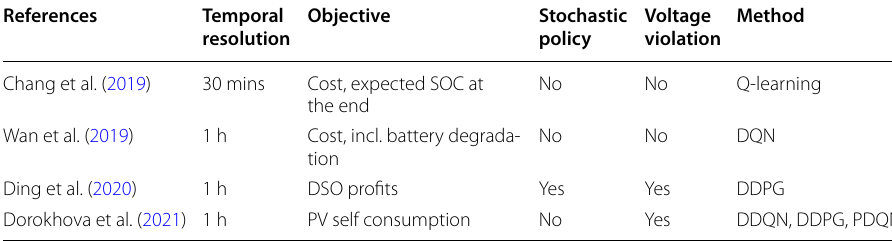
Table 1 Summary of some exemplary studies using RL for EV charging